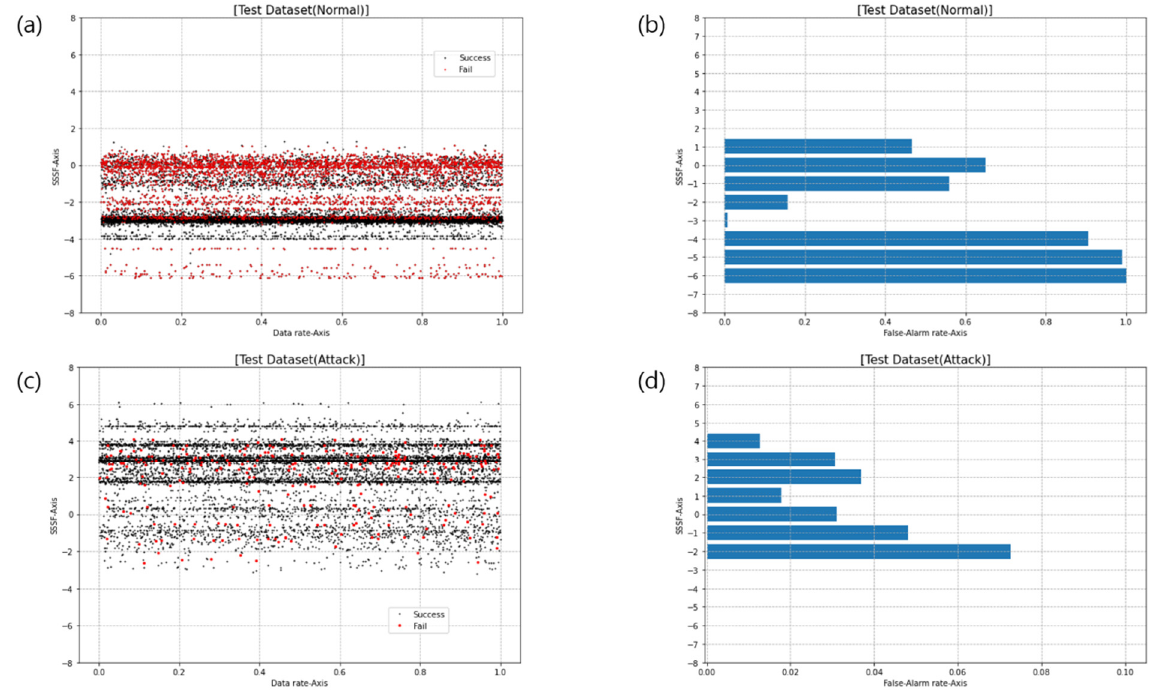
Figure 6. Prediction success/failure distribution in SSSF of IDS dataset: ( a ) success/failure distribu- tion of the data predicted as normal in the test dataset; ( b ) group of SSSF success/failure distribution of the data predicted as normal in the test dataset; ( c ) success/failure distribution of the data predicted as an attack in the test dataset; ( d ) group of SSSF success/failure distribution of the data predicted as an attack in the test dataset.